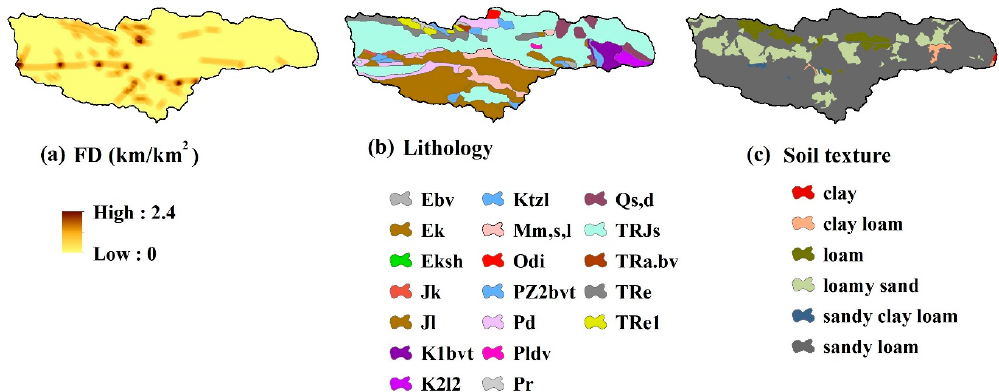
Figure 5. Geological factors: ( a ) fault density (FD), ( b ) lithology, and ( c ) soil texture.